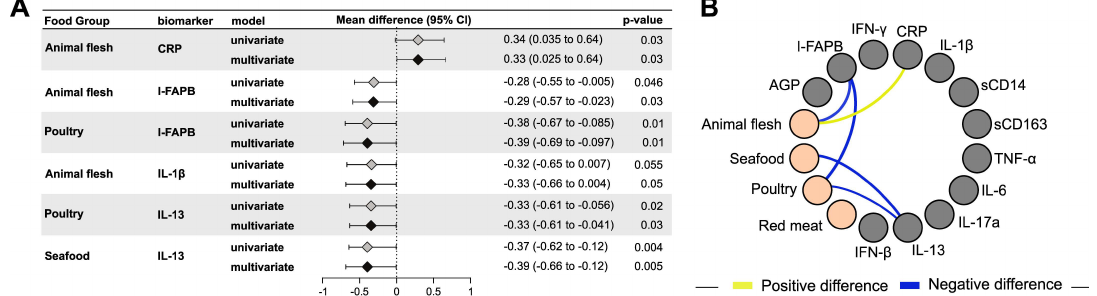
Figure 2. Association of animal flesh intake with markers of inflammation.Using linear regression, Table 2. concentration of each inflammation markers and 95% CI per unit (log e grams/day) change in total animal flesh (poultry + red meat + seafood) intake is shown in Figure 2. We further assessed the relationship of inflammation markers by unit change (log e grams/day) of sub-categories of animal flesh: (i) poultry, (ii) red meat and (iii) seafood. Only significant results ( p < 0.05) in univariable or multivariable analyses are shown in the forest plot (Figure 2 A ), with complete data shown in Supplementary Tables S5 and S9–S11. The network graph (Figure 2 B ) shows statistically significant mean differences of inflammatory markers (gray nodes) for each food group (green nodes). Positive or negative mean differences are represented by yellow or blue edges, respectively. The size of the edges is proportional to log 2 mean differences. Only significant ( p < 0.05) multivariable models are shown in this chart. Univariable models are adjusted for average daily energy intake and multivariable models are adjusted for daily energy intake, HIV status, age, education, gestational age at sampling and current smoking status.